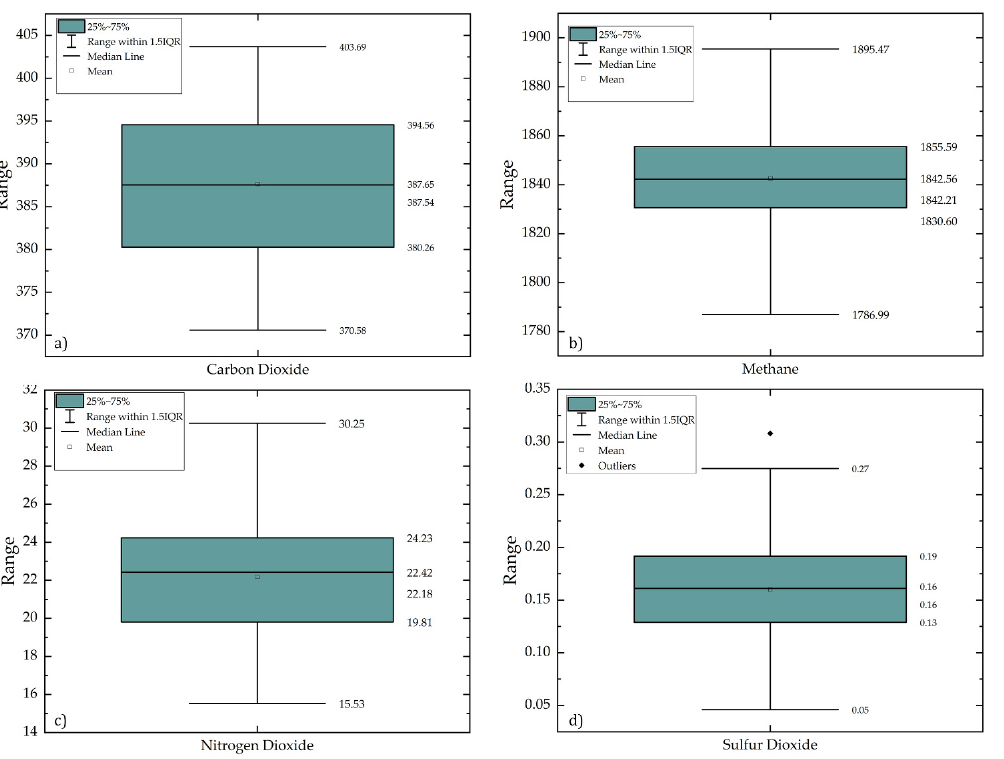
Figure 2. Box and whiskers plot after pre-processing (outlier and noise removal) for ( a ) carbon dioxide, ( b ) Methane, ( c ) Nitrogen dioxide, and ( d ) Sulphur dioxide.